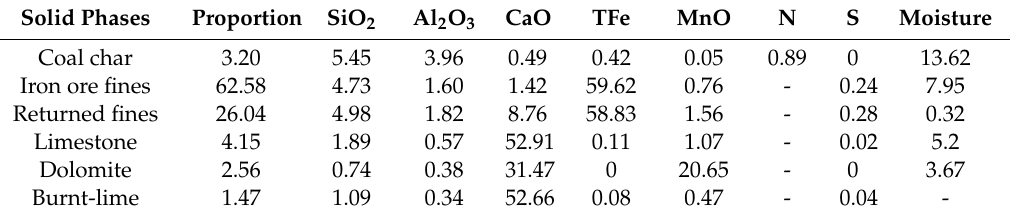
Figure 2. Flue gas recirculation sintering (FGRS). Table 2. Proportion and chemical composition of raw materials for sintering